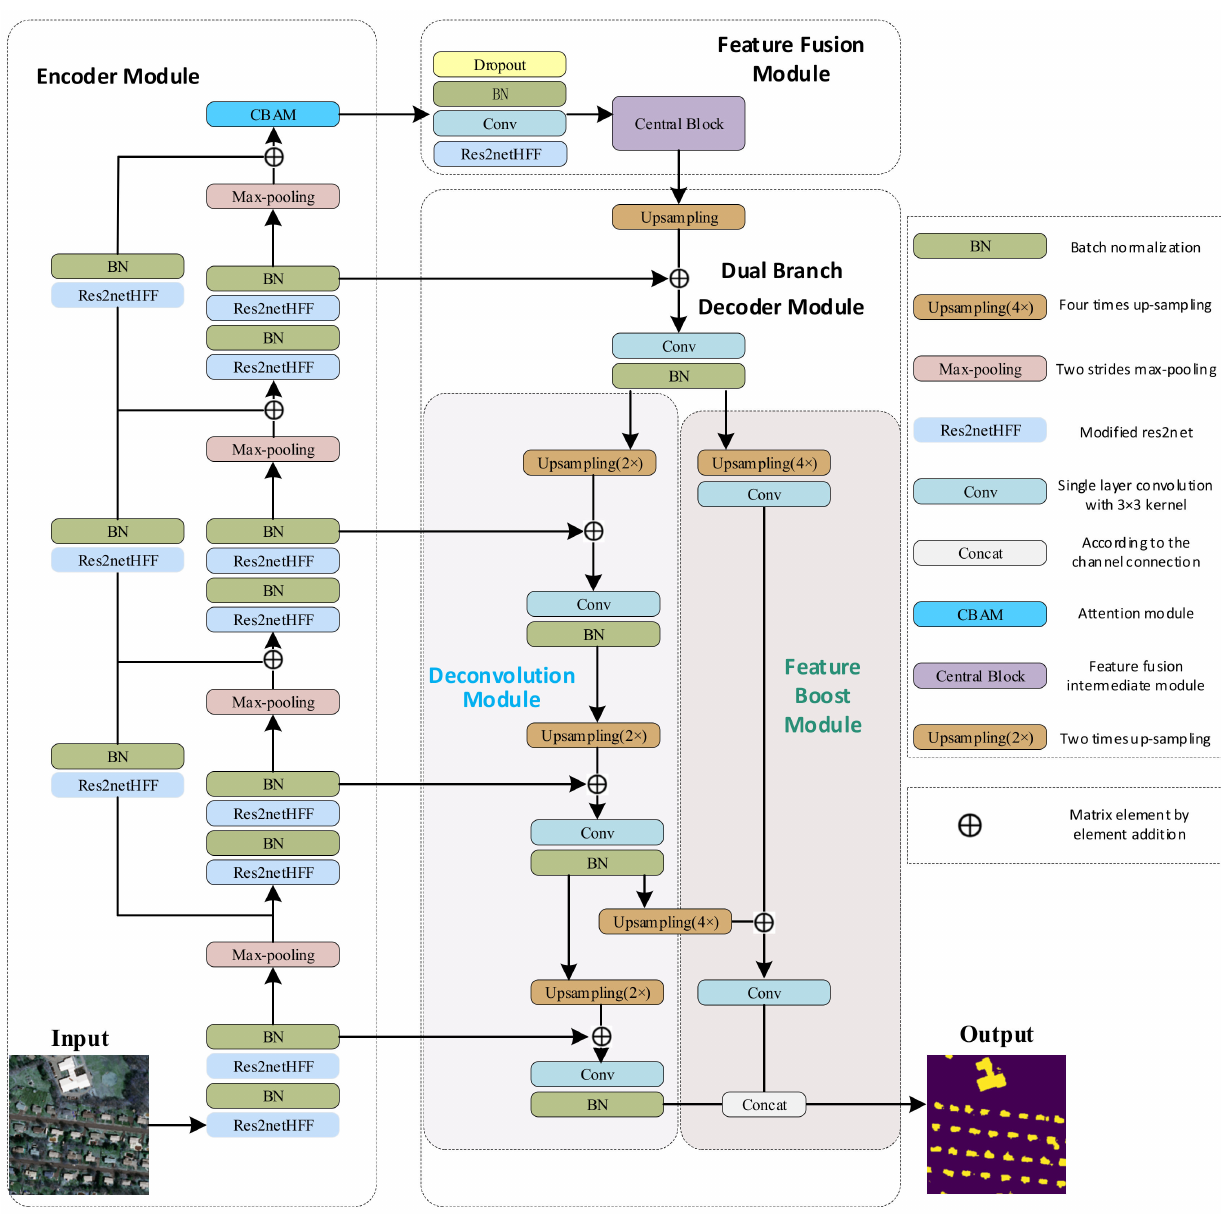
Figure 1. Overall Architecture of our single-side dual-branch network